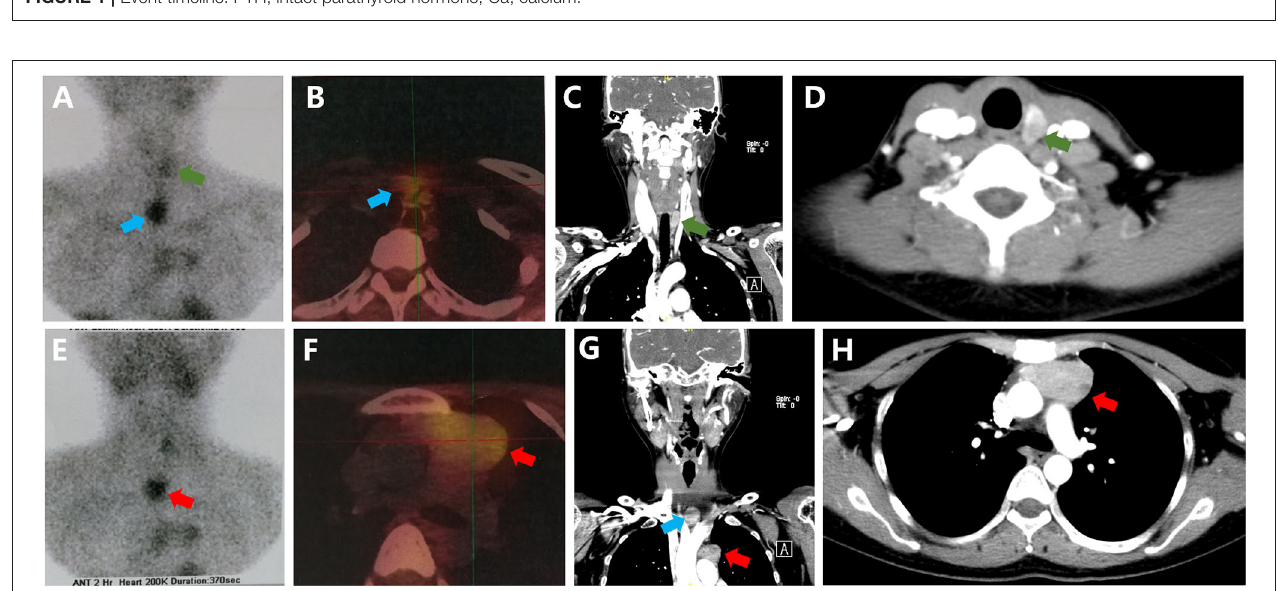
FIGURE 1 | Event timeline. PTH, intact parathyroid hormone; Ca, calcium.